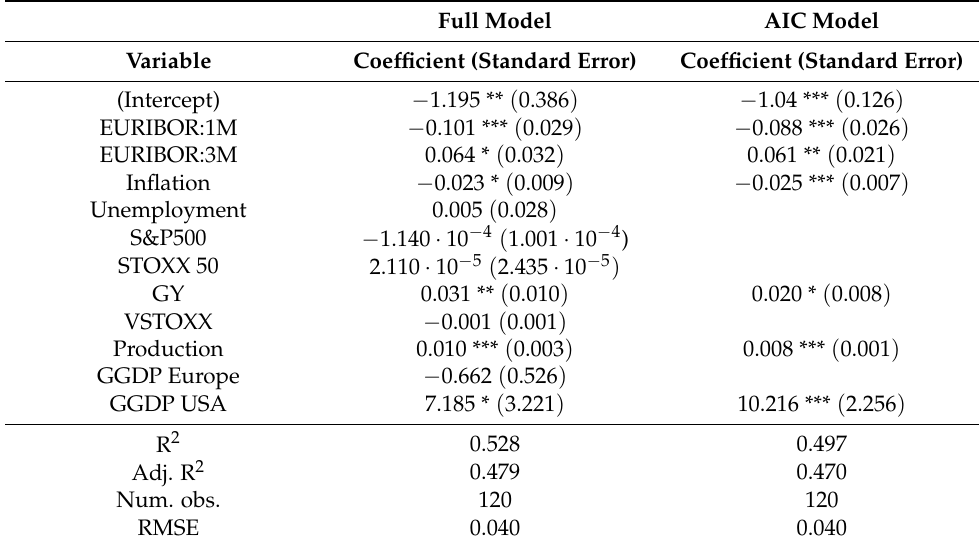
Table 2. Fitted linear regression (4) with unshifted variables before and after model